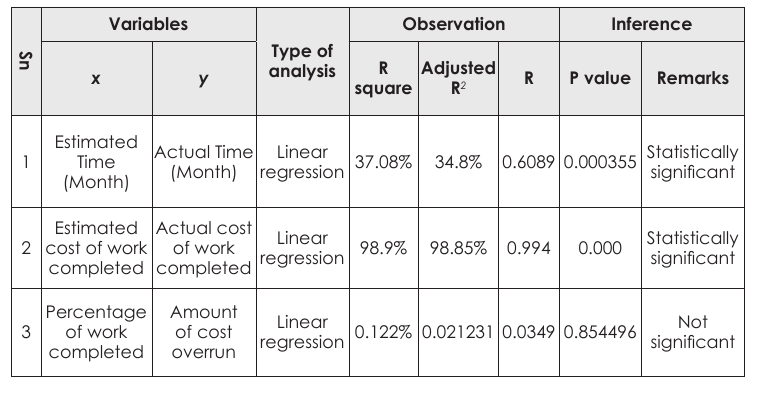
Results of the linear regression analyses Variables Observation Type of S n analysis